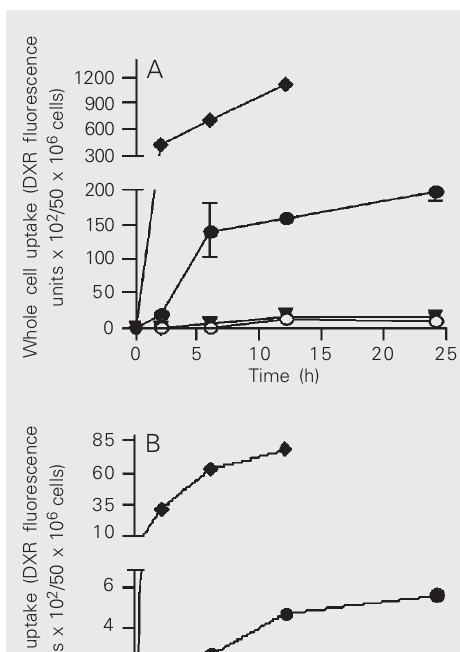
Figure 4. Kinetics of DXR or DXR-containing liposome up- take by SCLC H82 cells. Twenty